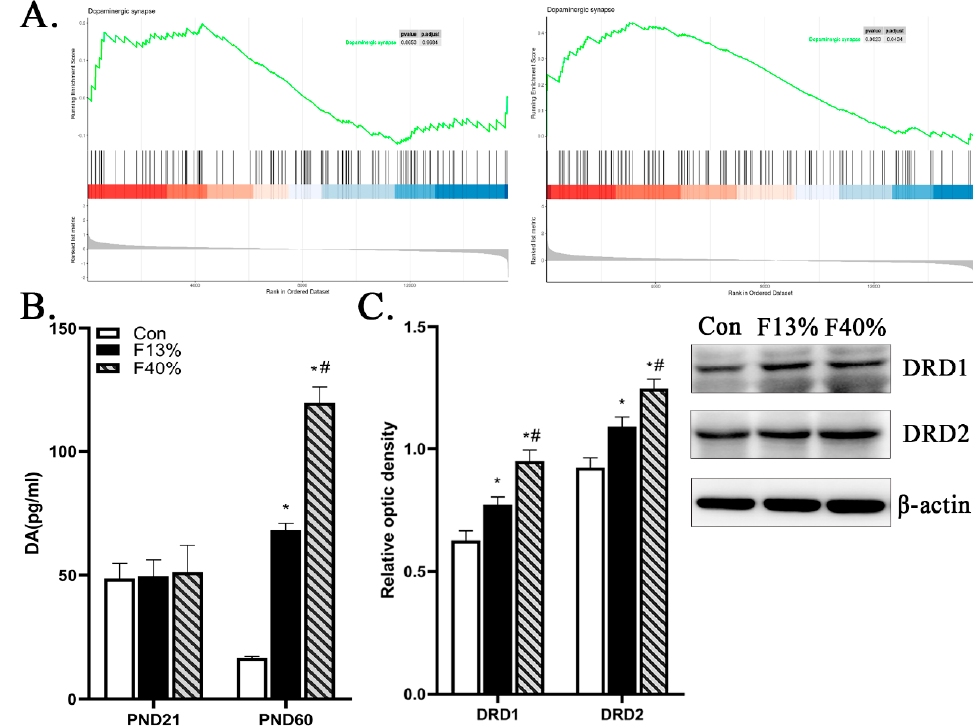
Figure 6. Changes in dopamine (DA) and dopaminergic synapse. ( A ) GSEA results of “dopaminergic synapse” of Con/F13% and Con/F40%. The abscissa represents the location of the ranked transcript set, and the ordinate indicates log 2 (fold change). The bottom part of the graph is the sequence quantity distribution, and the green line in the top part is the transcript enrichment score. ( B ) The DA level of PND21 and PND60 offspring. ( C ) The representative immunoblots and densitometry analysis of DRD1 and DRD2. Note: Every group n = 6; each bar represents mean ± SEM; * p < 0.05 (vs. control group); # p < 0.05 (vs. 13% fructose). Con, control group; F13%, 13% fructose group; F40%, 40% fructose group.